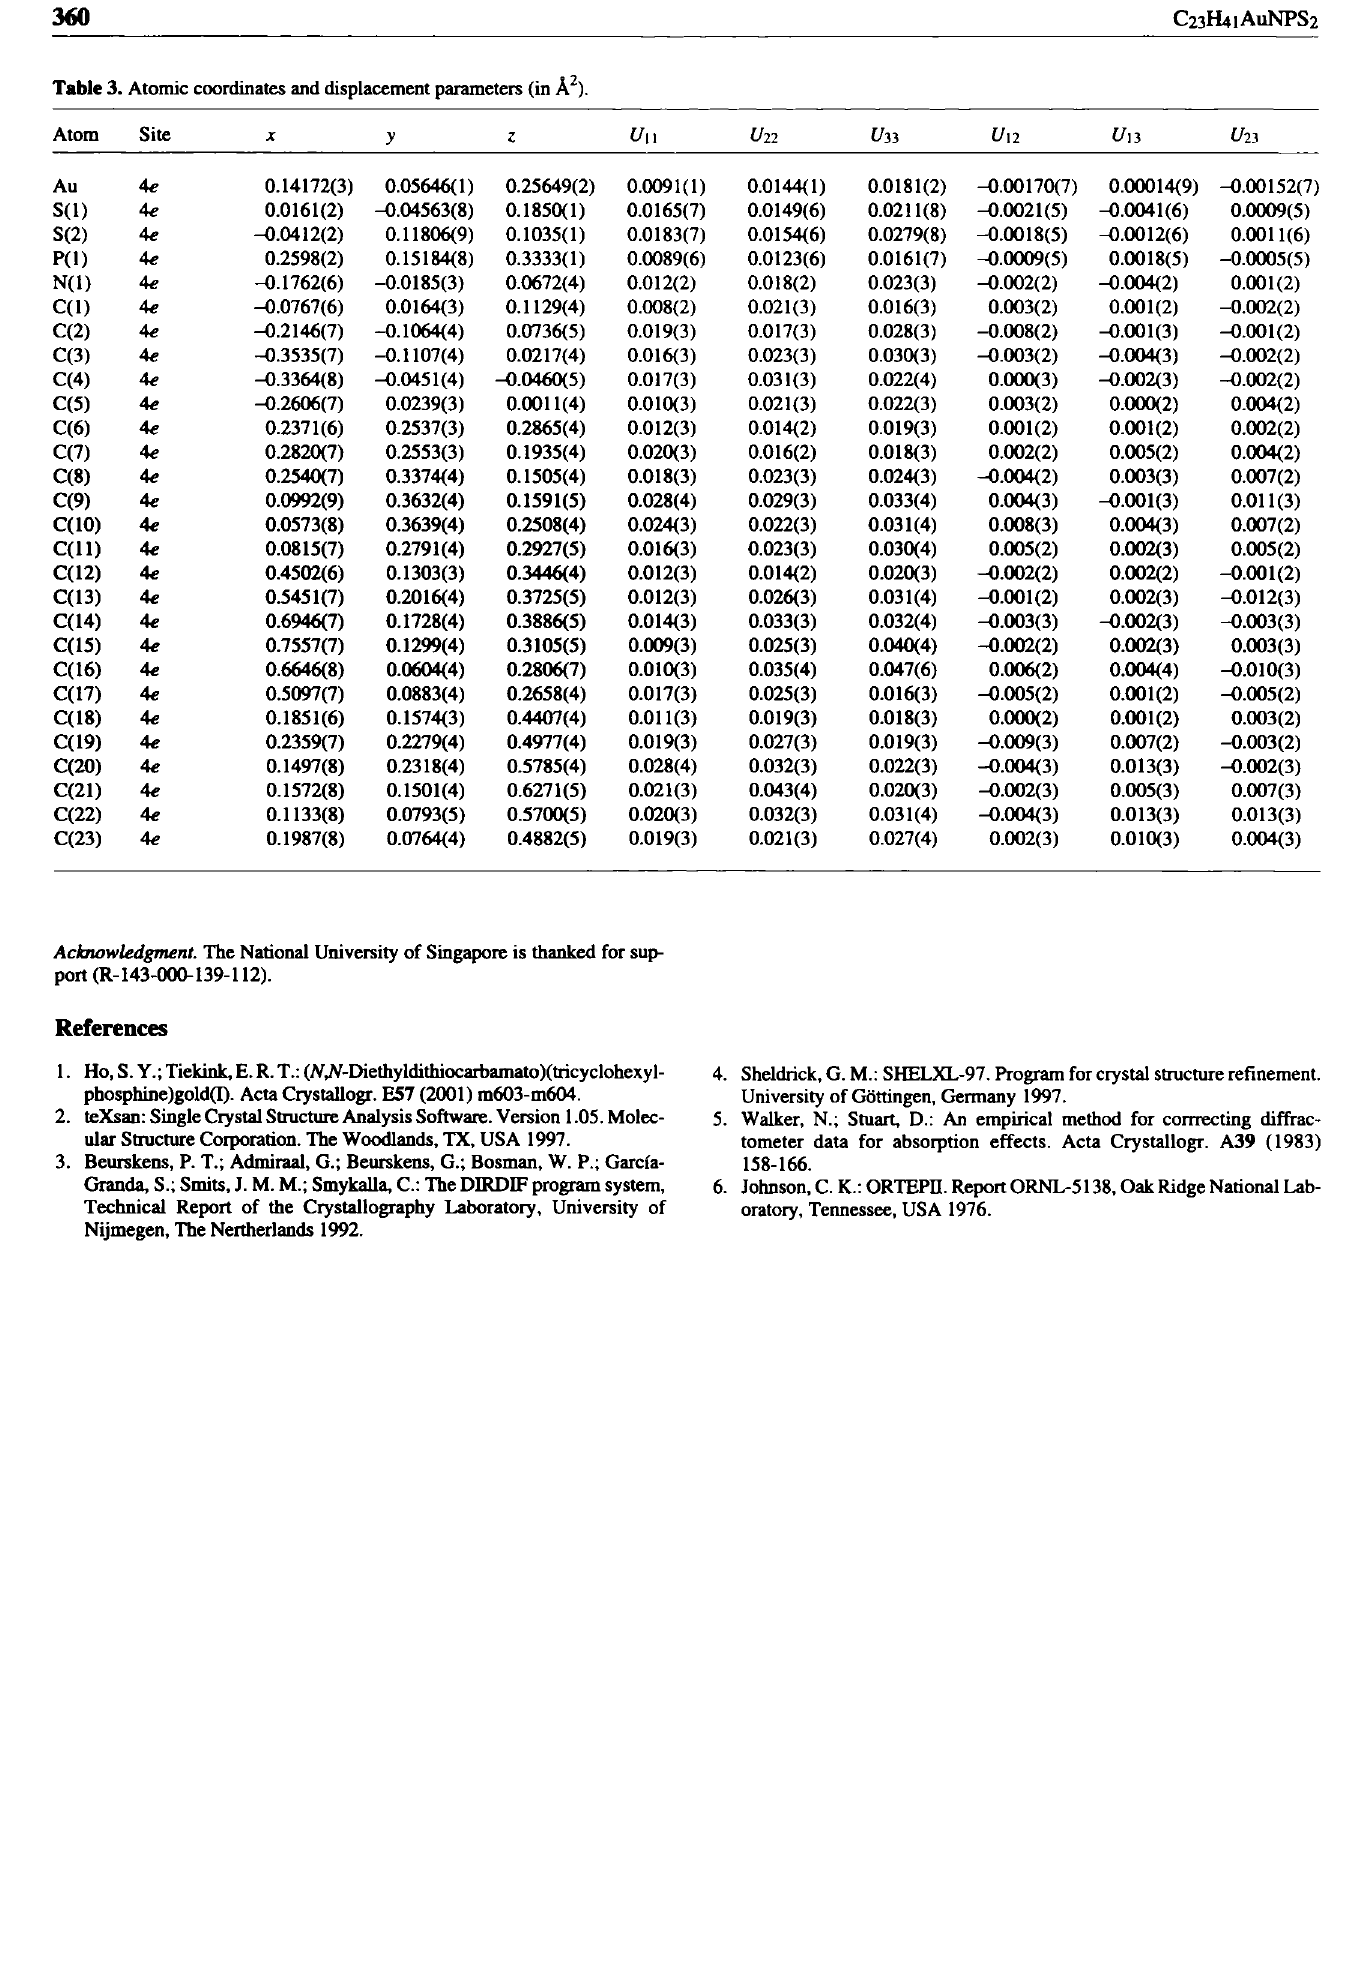
Table 3. Atomic coordinates and displacement parameters (in Â 2